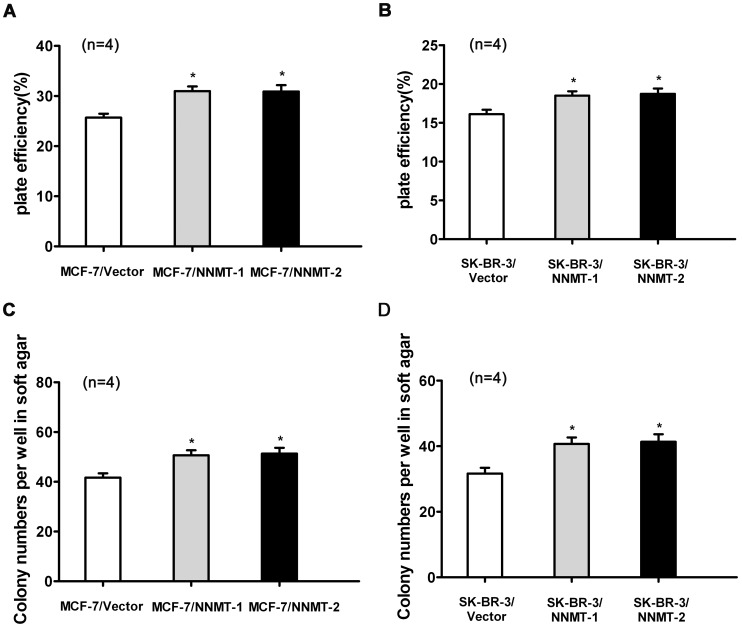
Overexpression of NNMT increased the plate efficiency and enhanced the capacity of colony formation in soft ager.(A, B) To test plate colony formation of MCF-7 and SK-BR-3 cells transfected with pcDNA3.1/NNMT, cells were placed in wells with media and incubated for 14 days before counting the number of colonies (foci>50µm). The plate efficiency of MCF-7/NNMT-1 and MCF-7/NNMT-2 cells was higher than that of MCF-7/Vector group. The similar result was found in SK-BR-3 cell models (B). (C, D) The colony formation numbers of MCF-7/NNMT-1 and MCF-7/NNMT-2 cells foci >100µm after 14 days were more numerous than that of MCF-7/Vector group (*P<0.05). The similar result was found in SK-BR-3 cell models (D). Values are expressed as means ± SD of four independent experiments.